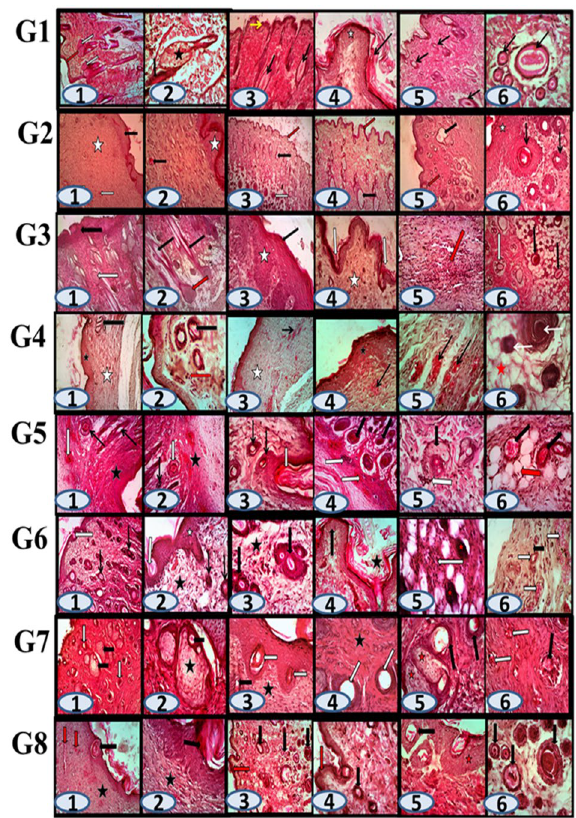
Figure 5. Histological view of skin wound for all studied groups stained with hematoxylin and eosin